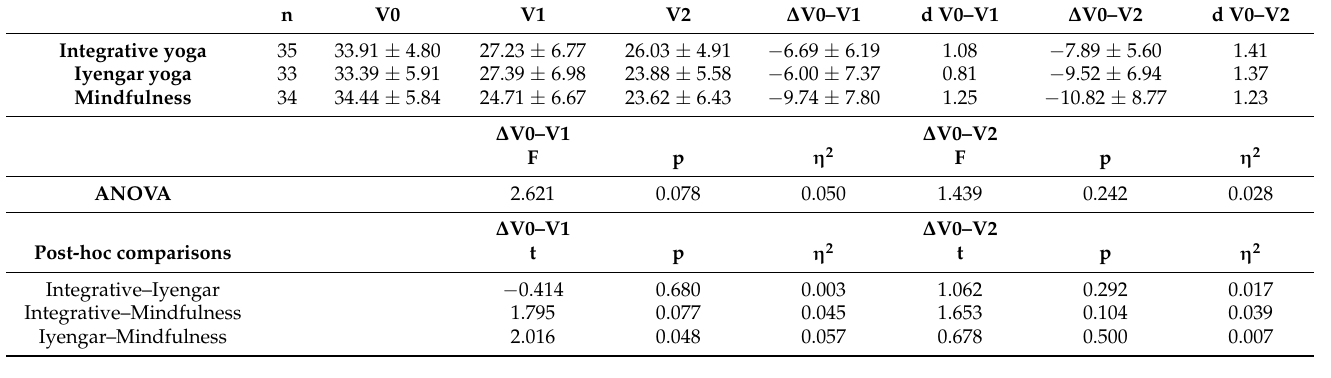
Table 3. Perceived Stress Scale (Primary Outcome—Mean ± SD).